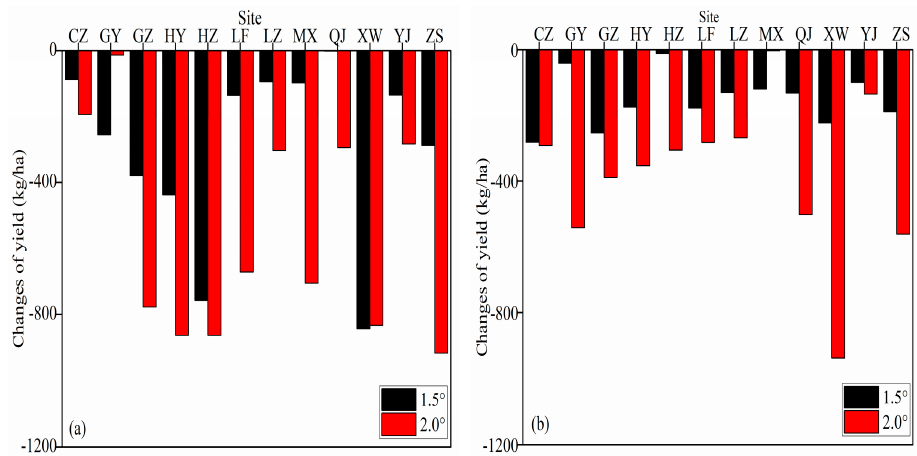
Figure 5. Changes of yields under the 1.5 and 2.0 °C warming scenarios relative to the baseline time for ( a ) early mature rice and ( b ) late mature rice.